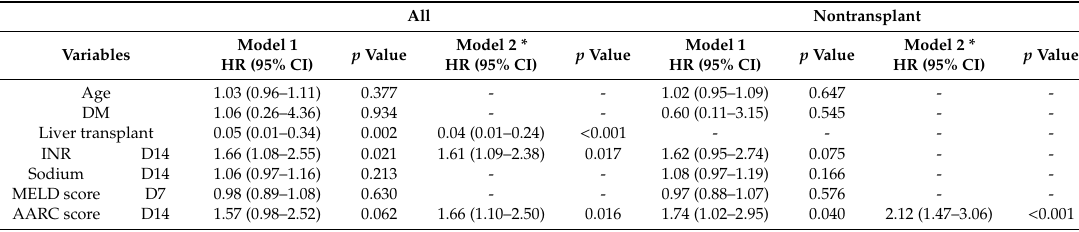
Table 4. Adjusted risk factors associated with overall